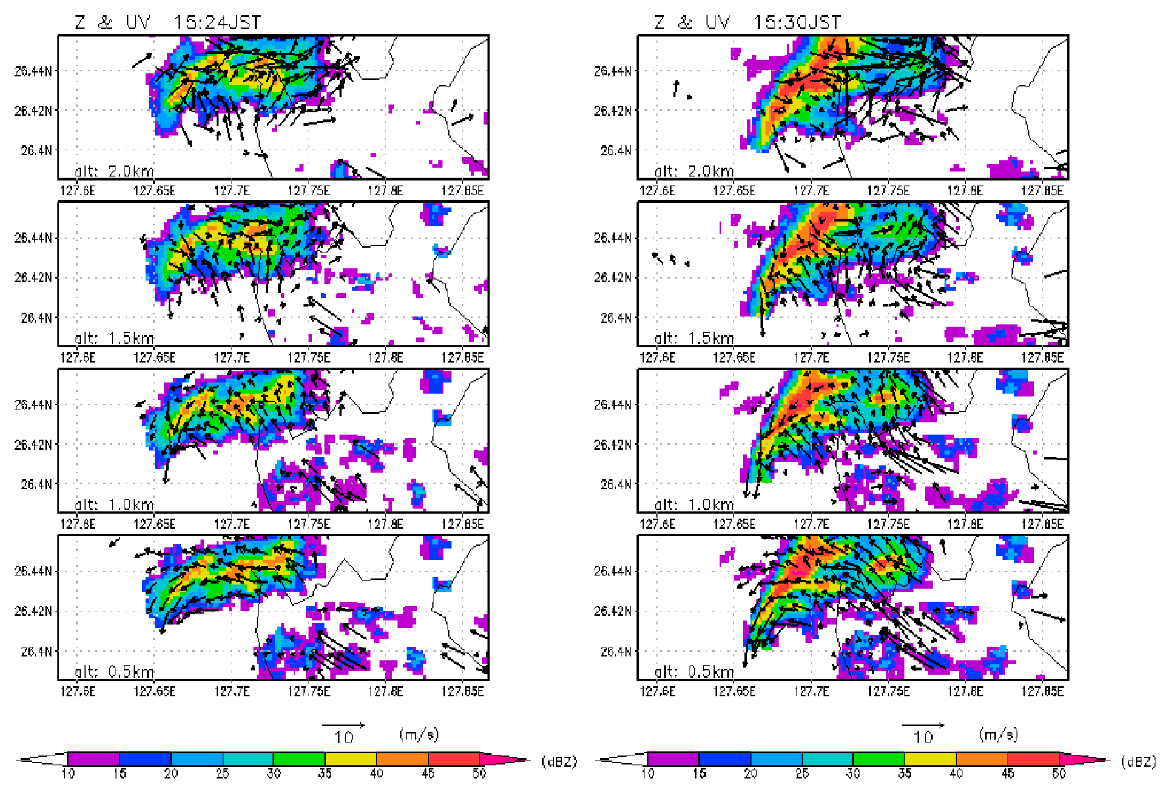
Figure 5. Horizontal wind field overlayed on the radar echo at altitudes of 0.5, 1.0, 1.5 and 2.0 km at 15:24 JST and 15:30 JST obtained from dual Doppler analysis using KIN radar and PAWR.